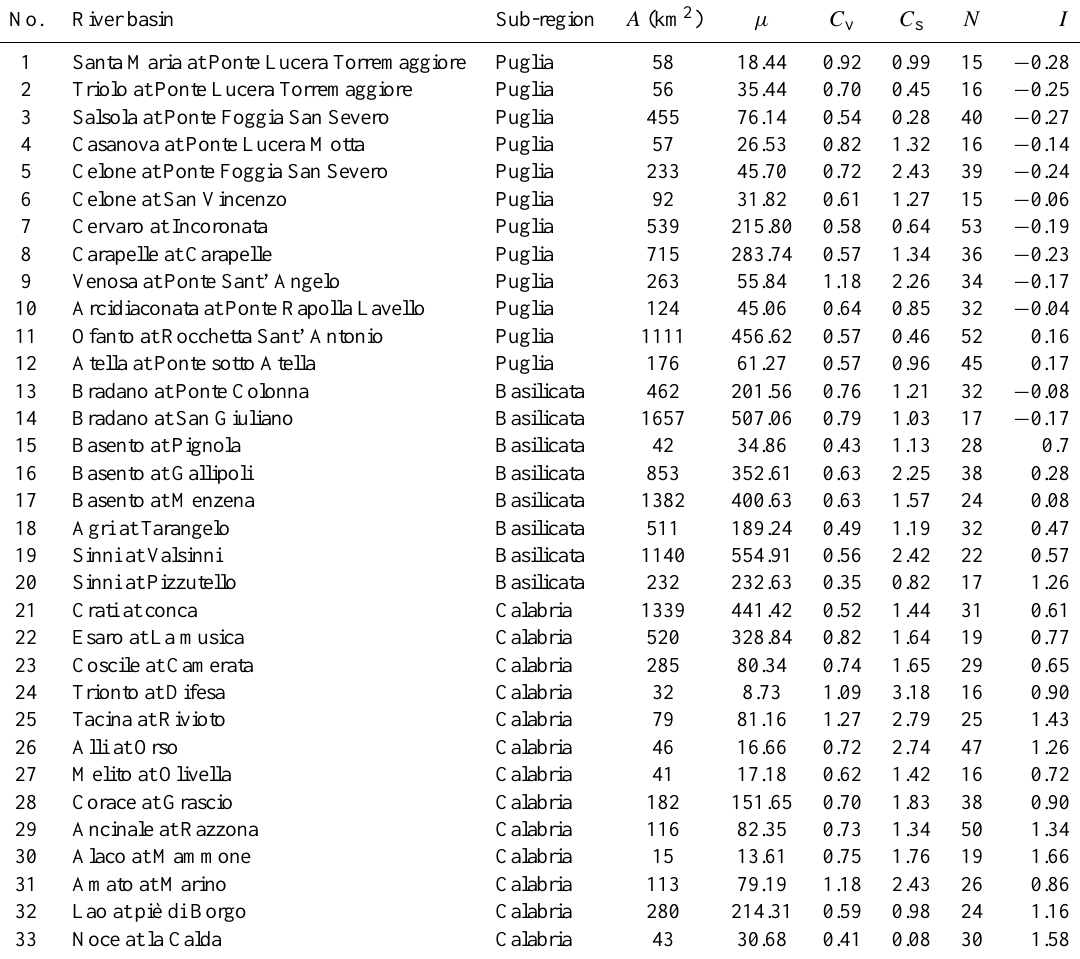
Table 1. Main features of the investigated